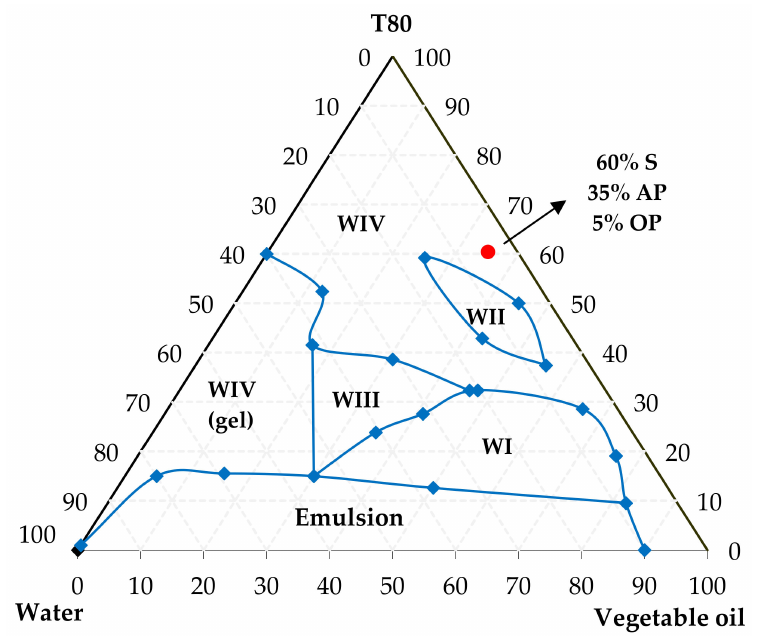
Figure 2. Ternary phase diagram for system 2 (vegetable oil / T80 / glycerol:water).